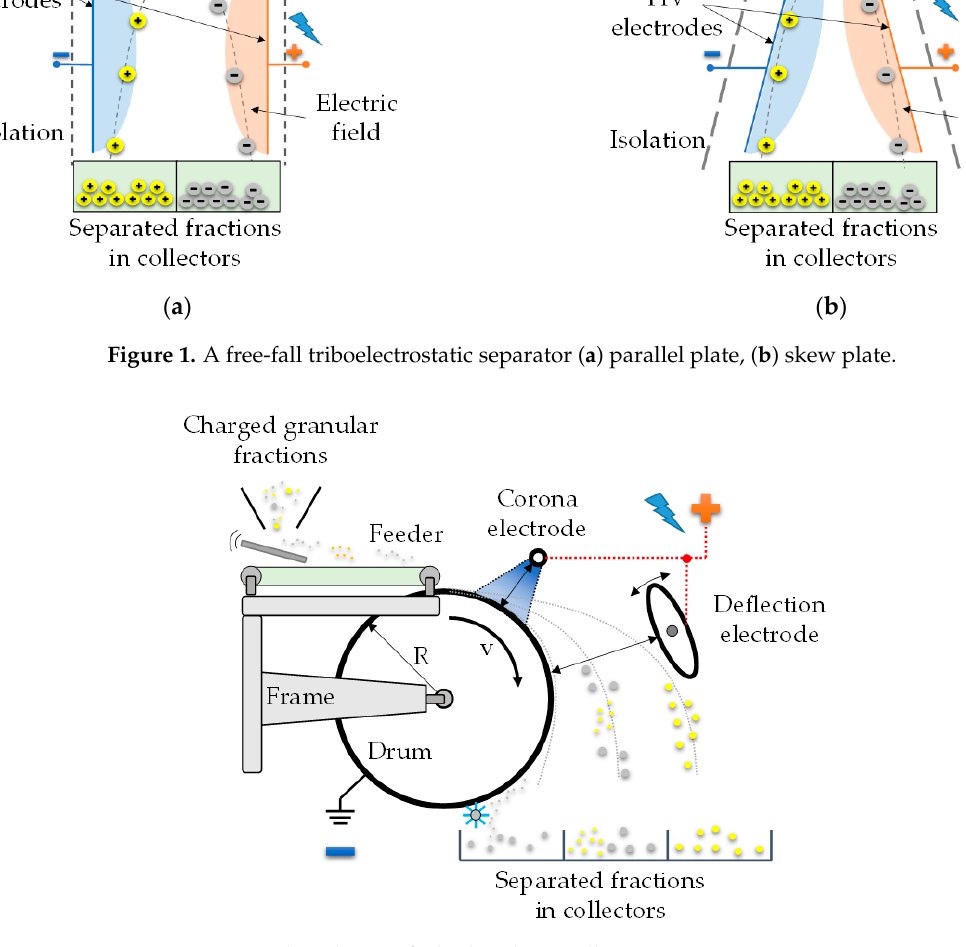
Figure 2. The scheme of a high voltage roll separator.